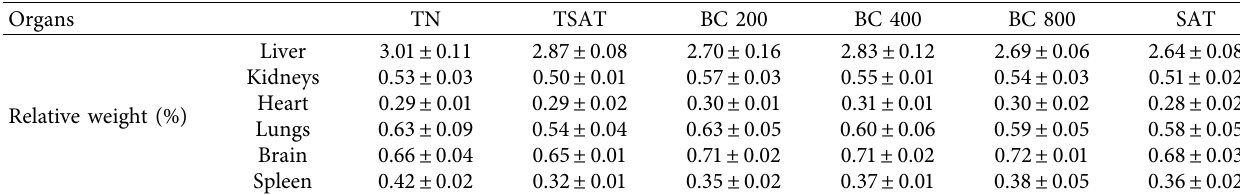
Each value represents the mean ± SEM. n � 5. TN: normal rats receiving distilled water (10mL/kg); TSAT: normal satellite observed 14 more days after stopping every treatment; BC 200, BC 400, and BC 800: animals receiving the aqueous extract of the mixture of B. pilosa and C. citratus at the respective doses of 200, 400, and 800mg/kg; SAT: satellite extract at the dose of 800mg/kg observed 14 days after stopping every